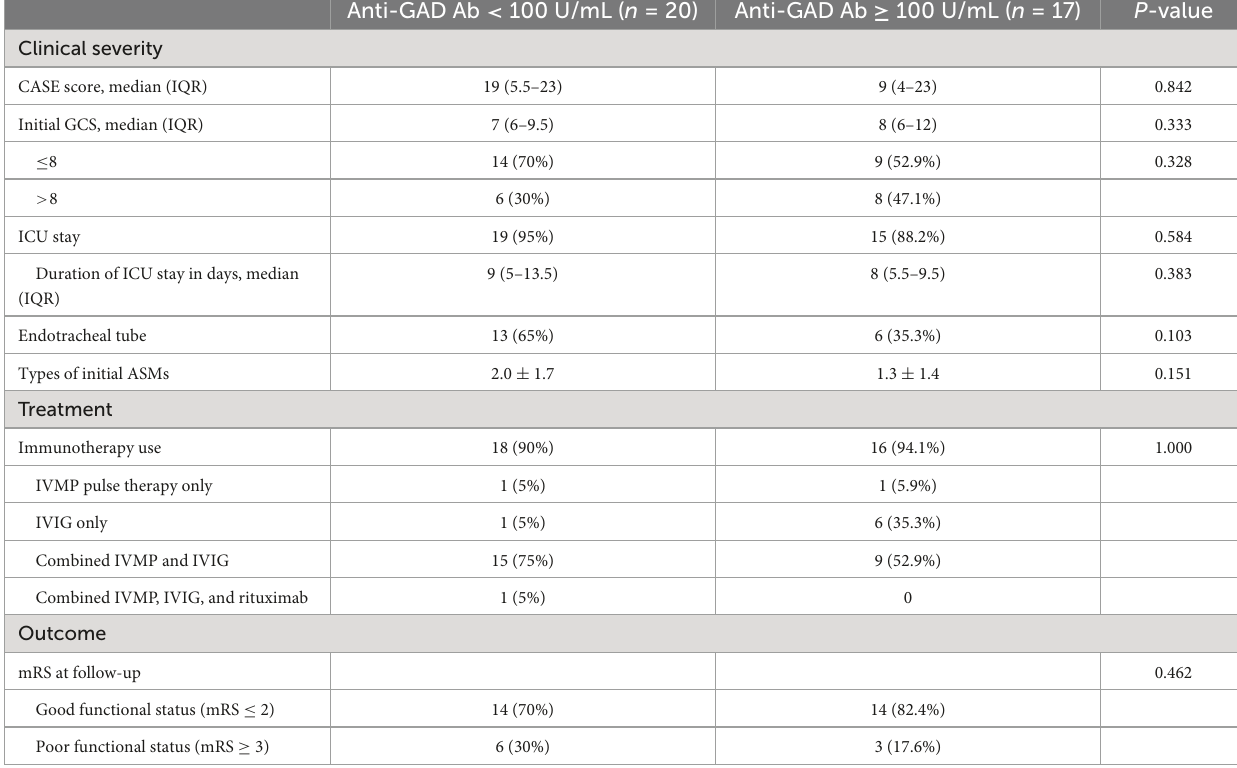
TABLE 2 Treatment, clinical severity, and outcomes of the patients with encephalitis/encephalopathy of the high- and low-titer anti-GAD antibody groups. Anti-GAD Ab < 100 U/mL ( n = 20)